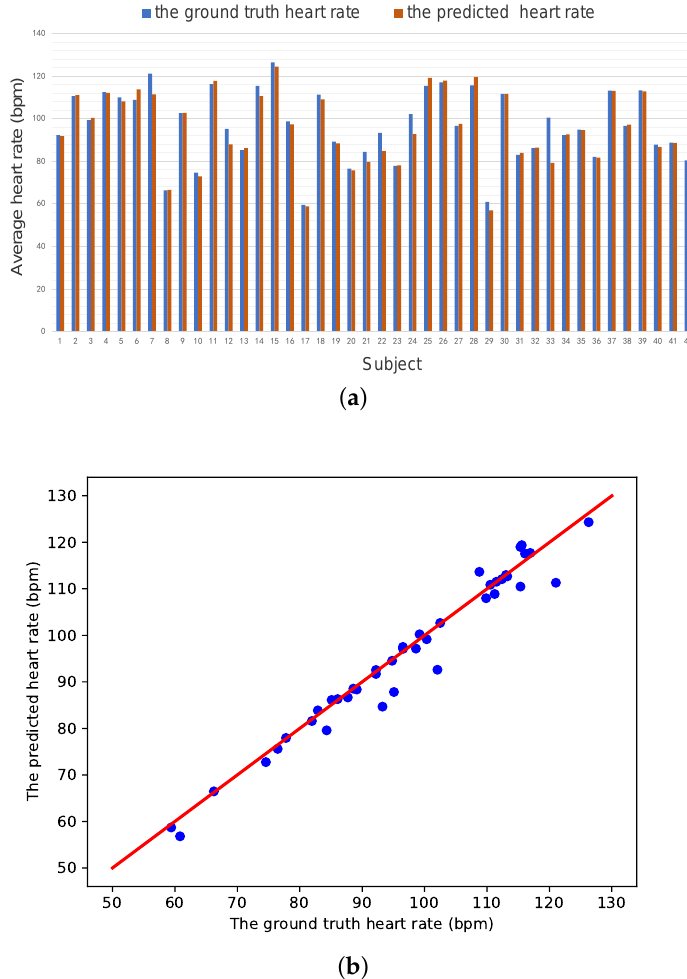
Figure 5. The ground-truth heart rate compared to the predicted heart rate of our method on the UBFC dataset. ( a ) Histogram of the H pred and the H gt . ( b ) Scatter plot comparing the H pred and the H gt on the UBFC